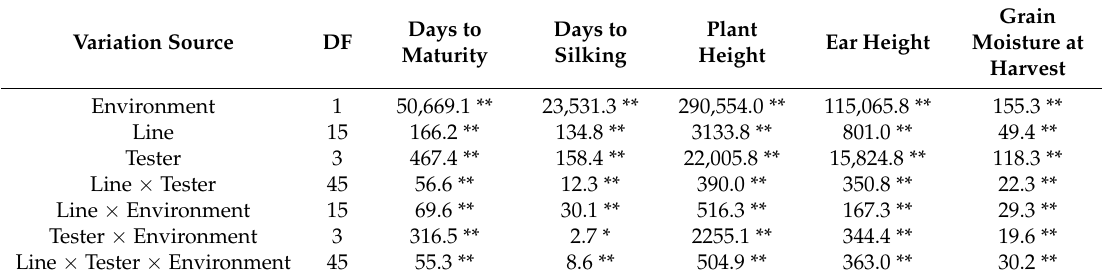
Table 8. Analysis of variance for the machine-harvesting characteristics of the hybrids derived from USA maize inbred lines crossed with China inbred testers grown in two locations in 2015. Days to Days to Plant Variation Source DF Maturity